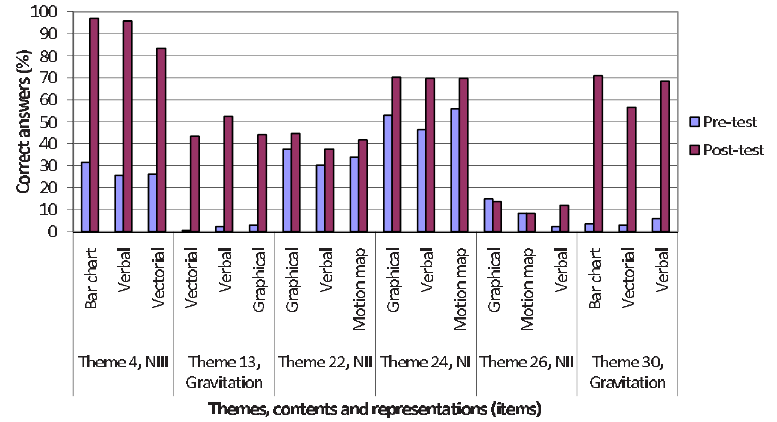
FIG. 6. (cid:1) Color (cid:2) The percentages of correct an- swers in the themes with statistically significant differences